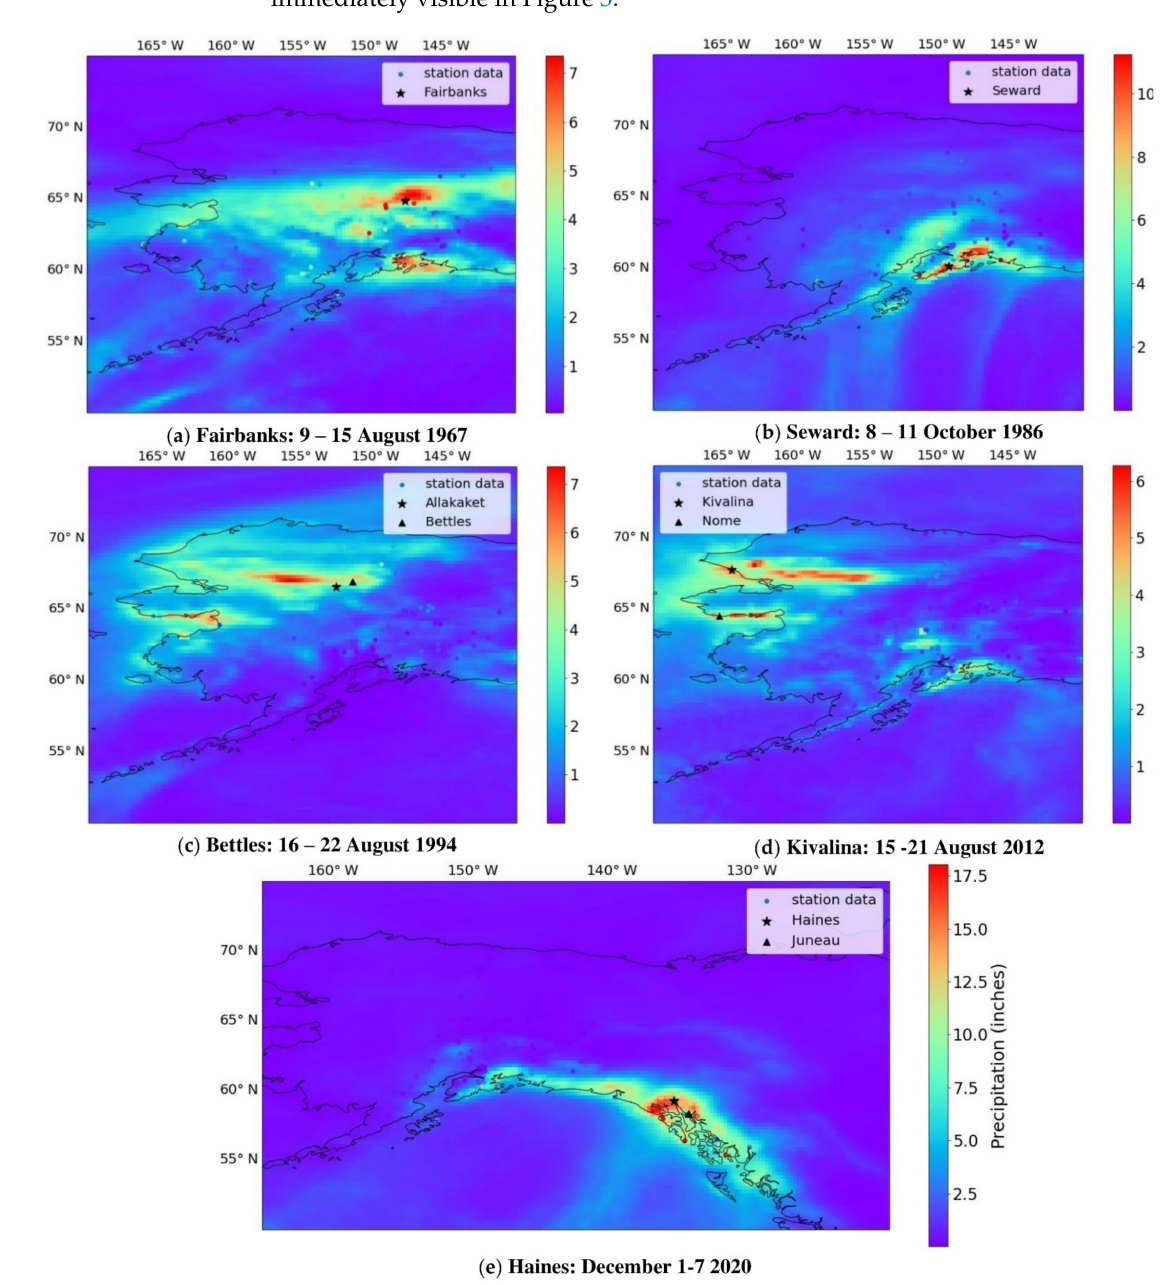
Figure 3. Distribution of precipitation amounts associated with each of the five flood events. Amounts (inches, color bar at right) are based on ERA5 reanalysis and are accumulated over the periods shown below each map. ( a ) Fairbanks: 9–15 August 1967, ( b ) Seward: 8–11 October 1986, ( c ) Bettles: 16–22 August 1994, ( d ) Kivalina: 15–21 August 2012, ( e ) Haines: 1–7 December 2020. Surface observing stations are shown as overlain dots, with their color corresponding to the color bar and indicating the amount of precipitation recorded at the station over the 7 day period. A star denotes the location of the observing station nearest each flood and a triangle denotes the location of secondary, more reliable, observing station when